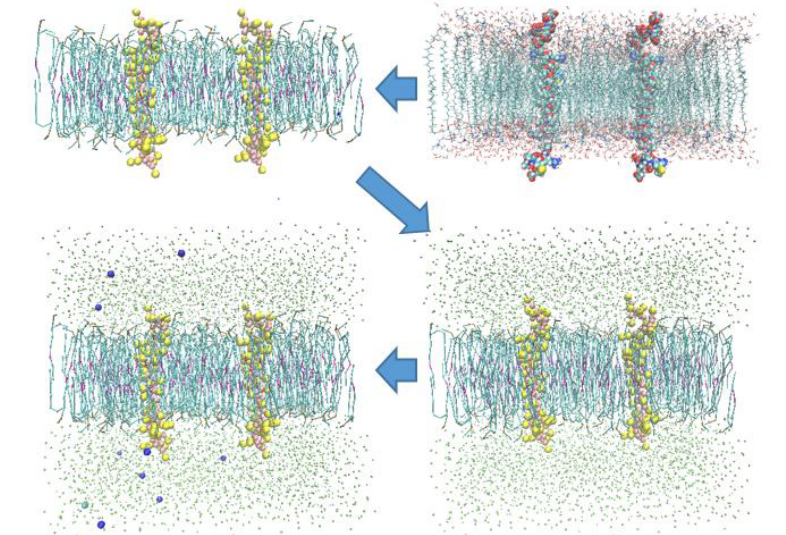
Figure 1. First, the all-atom model is prepared, then it is converted to the CG